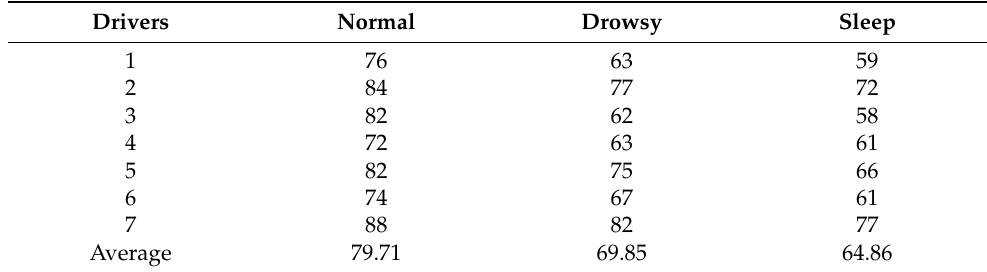
Table 7. Variations in heart rate of different drivers.